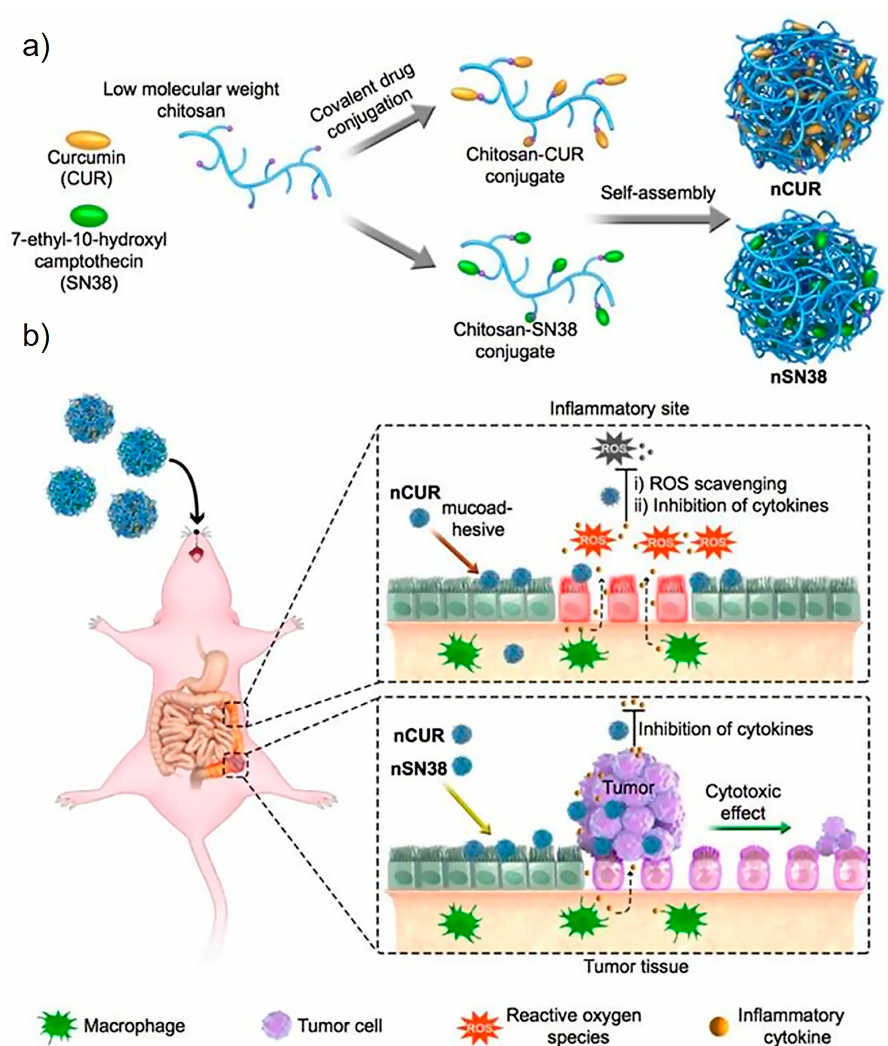
Figure 3. Schematic diagram of chitosan–drug conjugates self-assembling to form nanotherapeutic agents (i.e., nCUR and nSN38) and oral nanotherapeutic agents for CAC treatment. ( a ) SN38 and CUR therapeutics are separately attached to carboxylated chitosan by hydrolyzable bonds. The formed chitosan–drug conjugates self-assemble into stable colloids and bioadhesive nanotherapeutic agents that can be used for oral administration. ( b ) After water that contained the therapeutics ad libitum is drank to deliver the drug to the intestine, the nCUR and nSN38 nanotherapeutics are able to tightly adhere to intestinal villi and efficiently accumulate in the rodent’s inflamed colon tissues and tumors. Subsequently, intestinal inflammation and tumor growth are, respectively, suppressed with the gradual release of therapeutic drug components CUR and SN38. CUR: curcumin; SN38: 7-ethyl-10-hydroxycamptothecin. Adapted from Han et al.